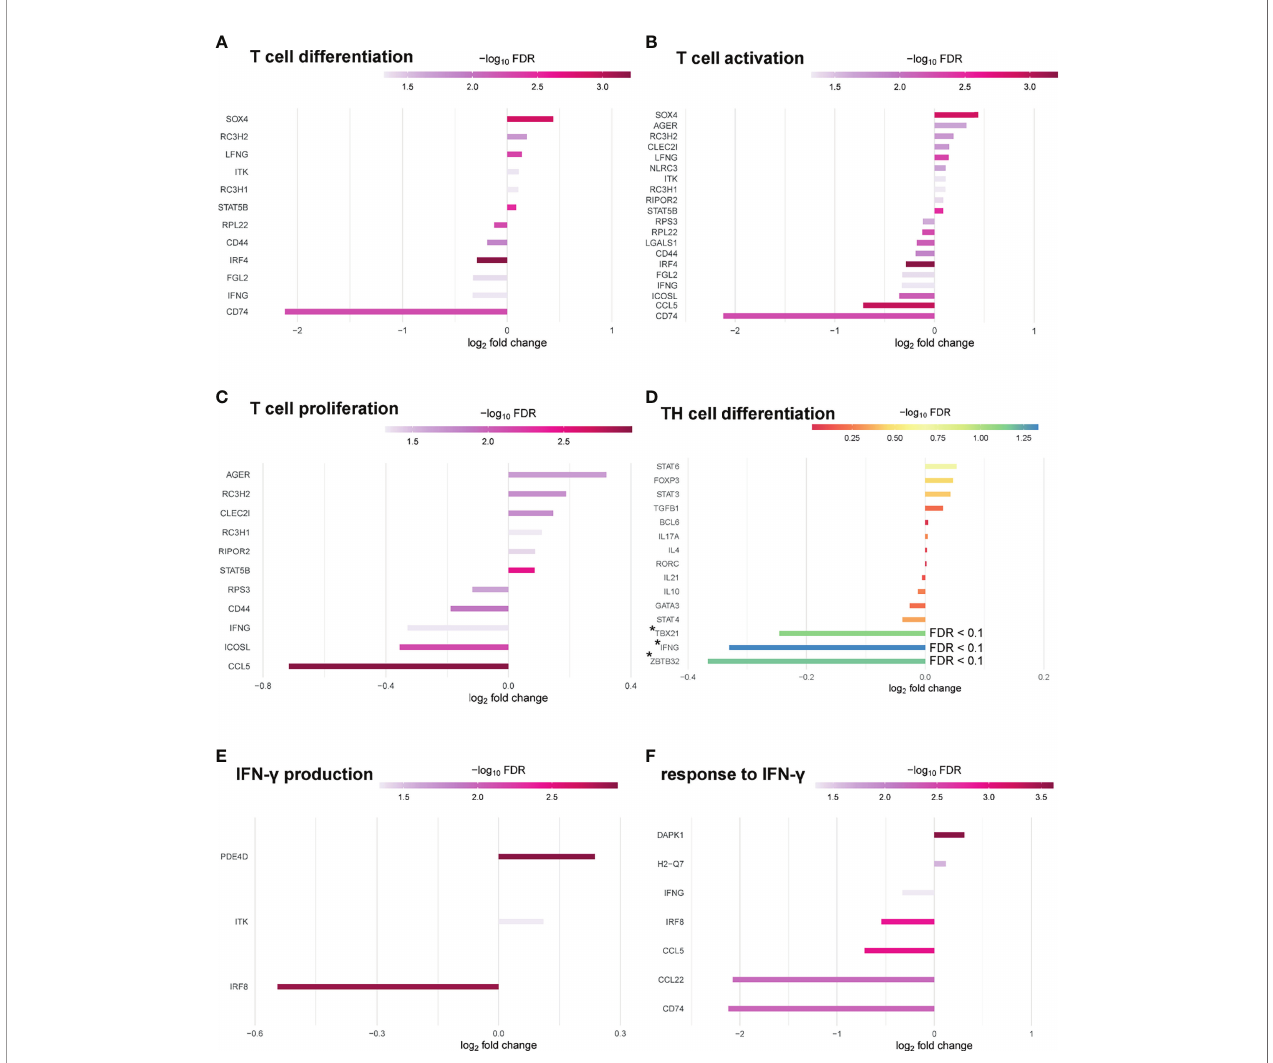
FIGURE 7 | BOB.1/OBF.1 involved in TH cell differentiation. (A – C) Waterfall plots showing differentially expressed genes between Pou2af1 fl / fl x CD4-Cre and CD4-Cre control mice at FDR 0.05 related to T cell differentiation (GO:0030217) (A) , T cell activation (GO:0042110) (B) and T cell proliferation (GO:0042098) (C) . (D) Waterfall plot showing differentially expressed genes related to TH cell differentiation at FDR 0.1. Differentially expressed genes with an FDR < 0.1 are highlighted with a *. (E, F) Waterfall plots showing DEGs between Pou2af1 fl / fl x CD4-Cre and CD4-Cre control mice at FDR 0.05 related to IFN- g production (GO:0032609) (E) and related to the response to IFN- g